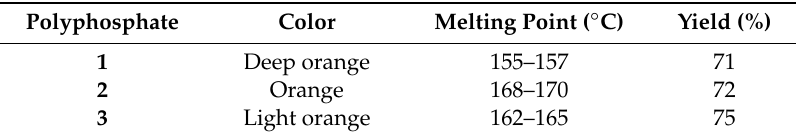
Figure 1. Polyphosphates 1 – 3 . Table 1. Color, melting points, and yields (%) of 1 – 3 .